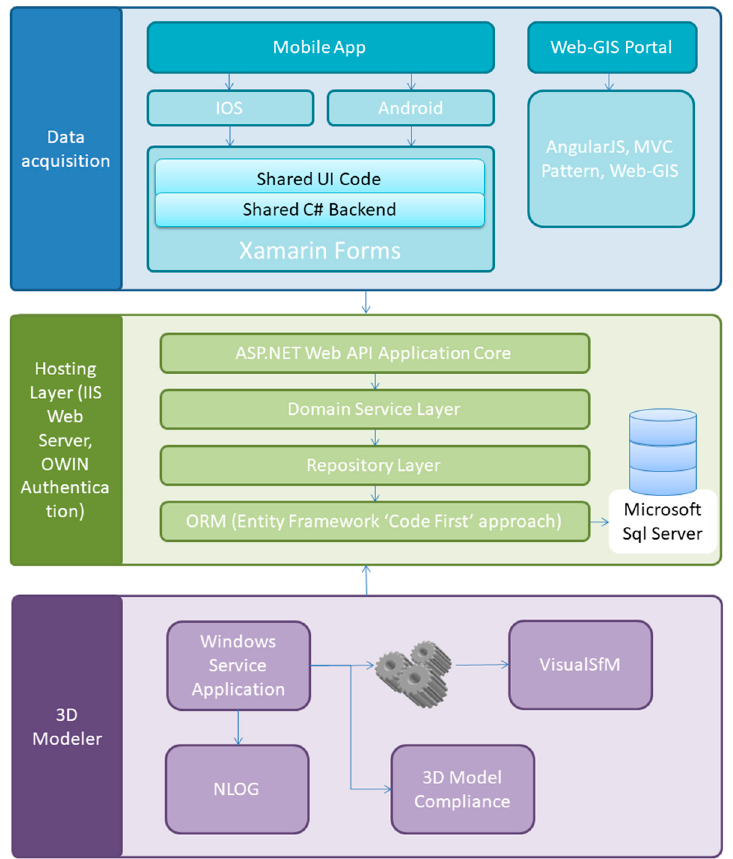
Figure 1. System architecture: data acquisition (upper panel), hosting layer (middle panel) and 3D modeler (lower